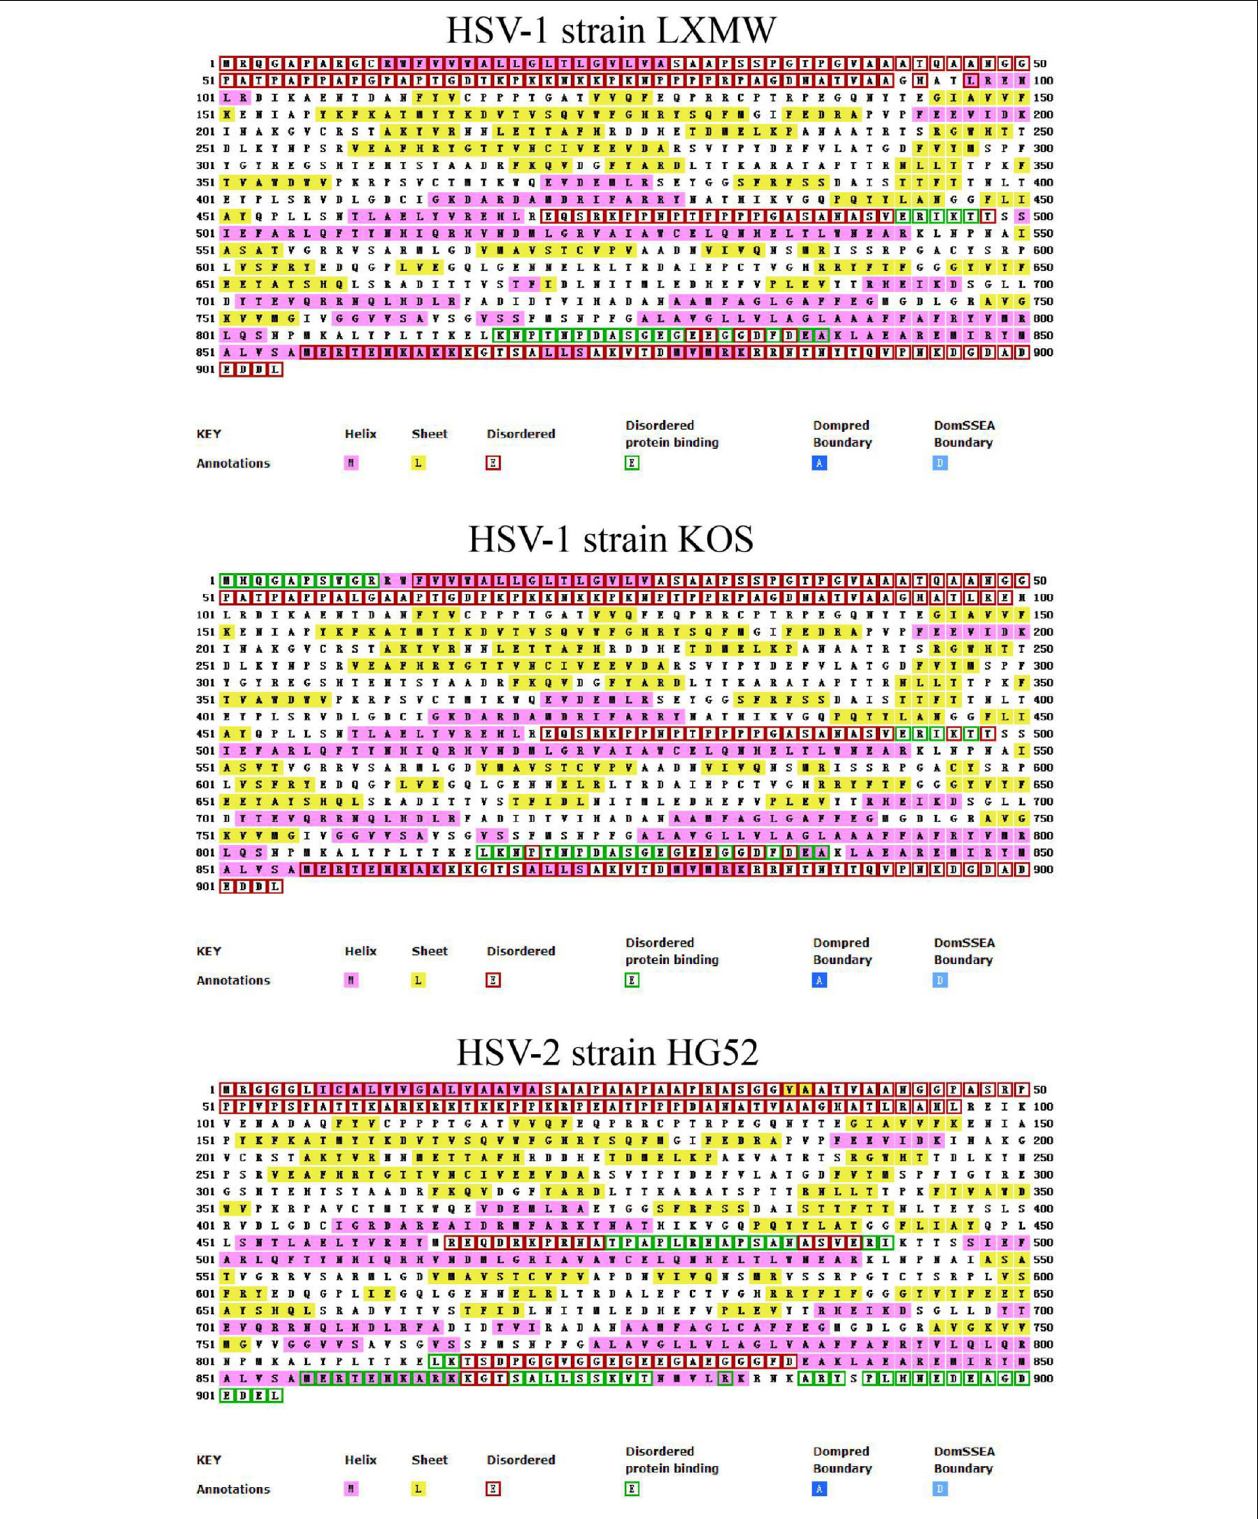
FIGURE 2 | The predicted gB secondary structures of HSV-1 strains LXMW and KOS as well as HSV-2 strain HG52.